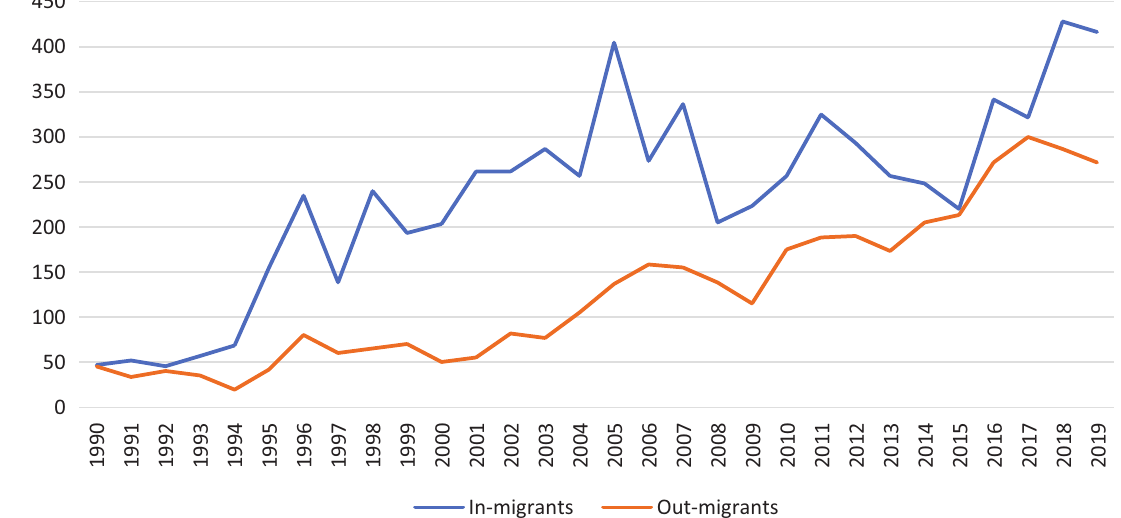
Figure 6. Number of migrants to and from Telki between 1990 and 2019 (in person). Source: Compiled by the authors based on data from HCSO (1990a, 1990b, 2001,